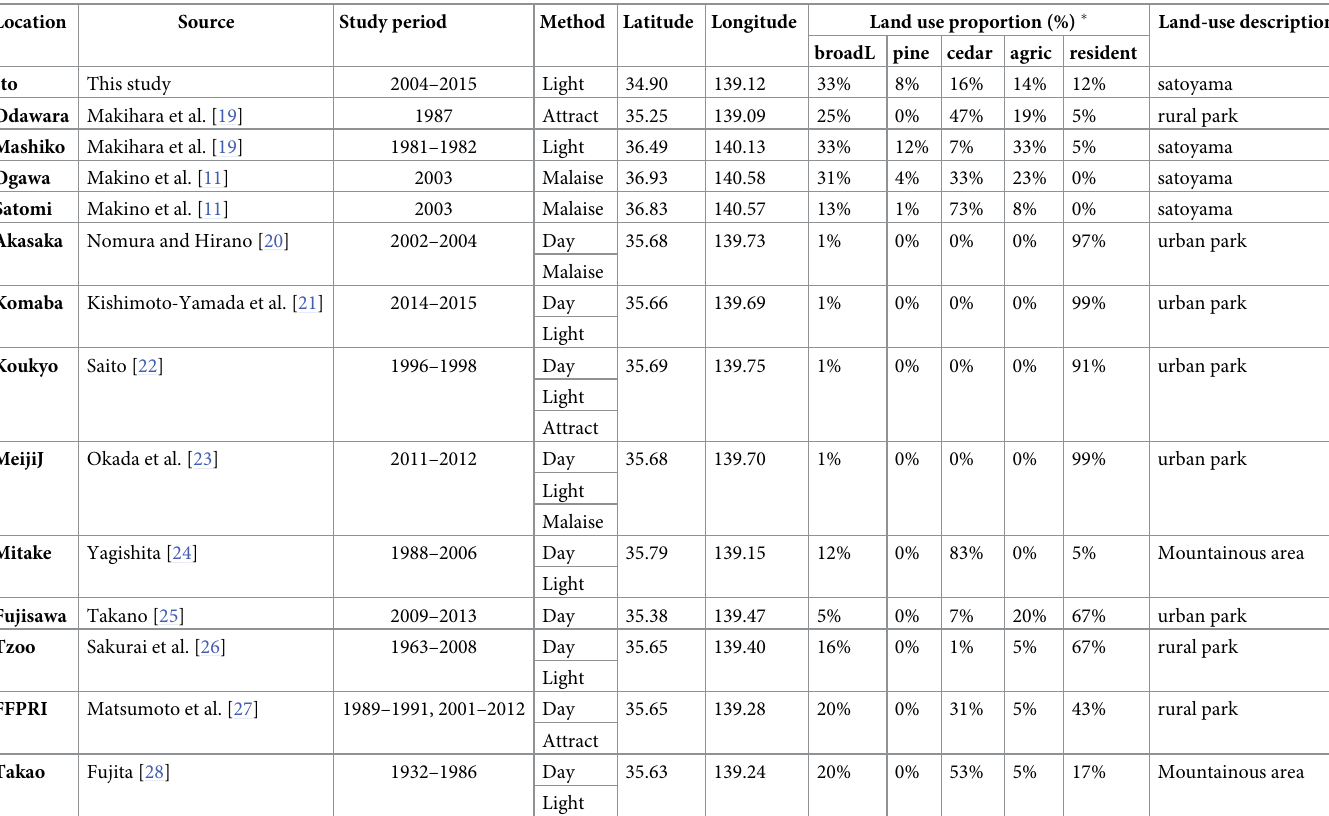
Table 1. Details of the longhorn beetle sampling sites in